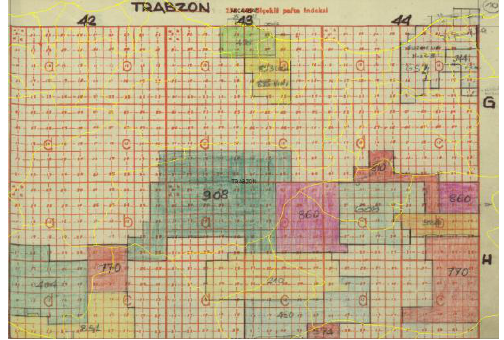
Figure 3. 1:250000 scale Trabzon sheet production index